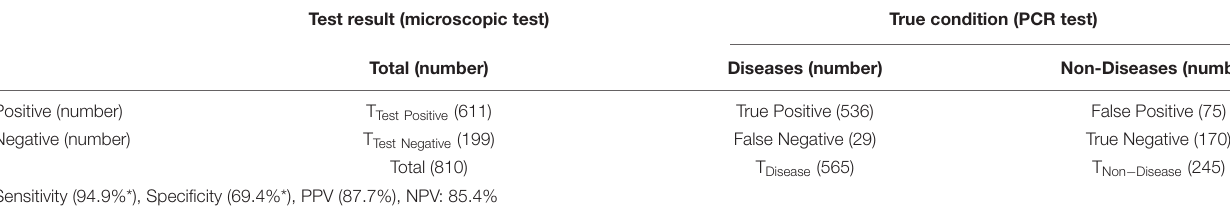
TABLE 2 | Sensitivity, specificity, and predictive values of diagnosis for the population tested in this